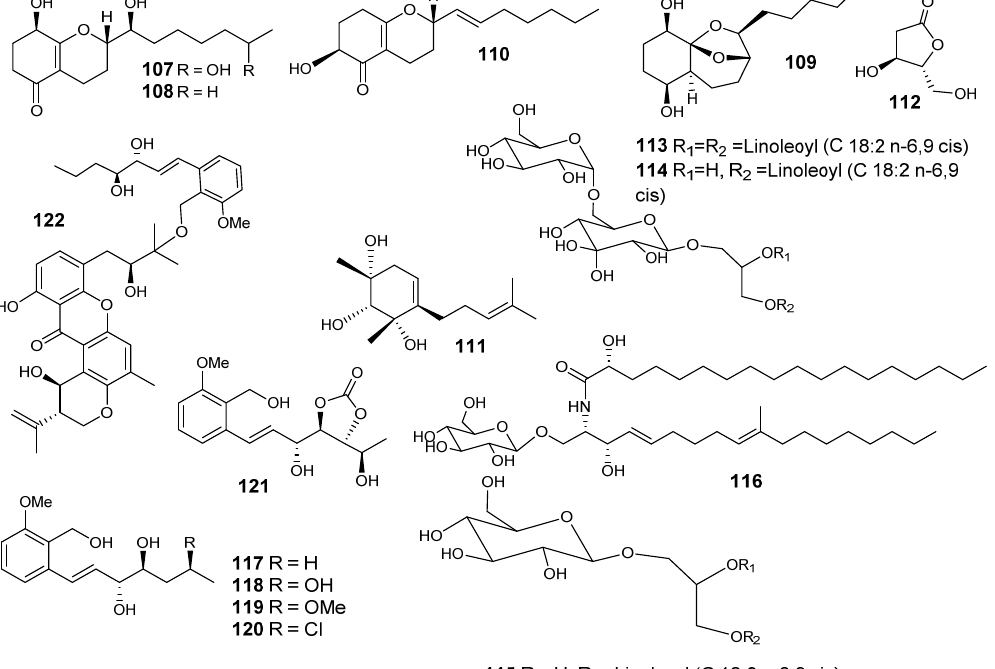
Figure 8. Structures of compounds 123–129. Diasteltoxins A − C ( 130 − 132 ) and asteltoxin ( 133 ) (Figure 9) were reported from marine E. variecolor XSA-07-2 [73]. Compounds 131 − 133 displayed inhibitory effects against H1299 and MCF7, while they displayed observed inhibitions against thioredoxin reductase (TrxR). Two closely